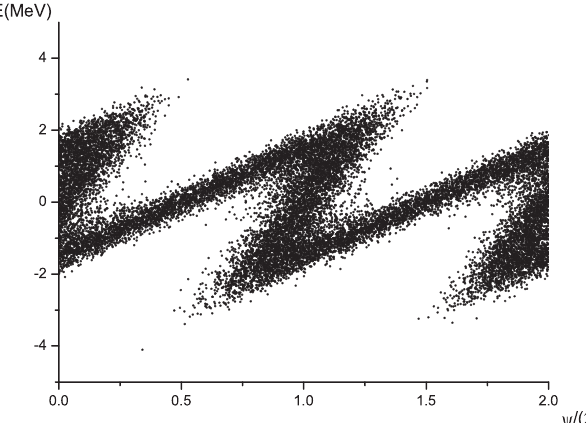
FIG. 3. A fraction of the longitudinal phase space after the last chicane of stabilization